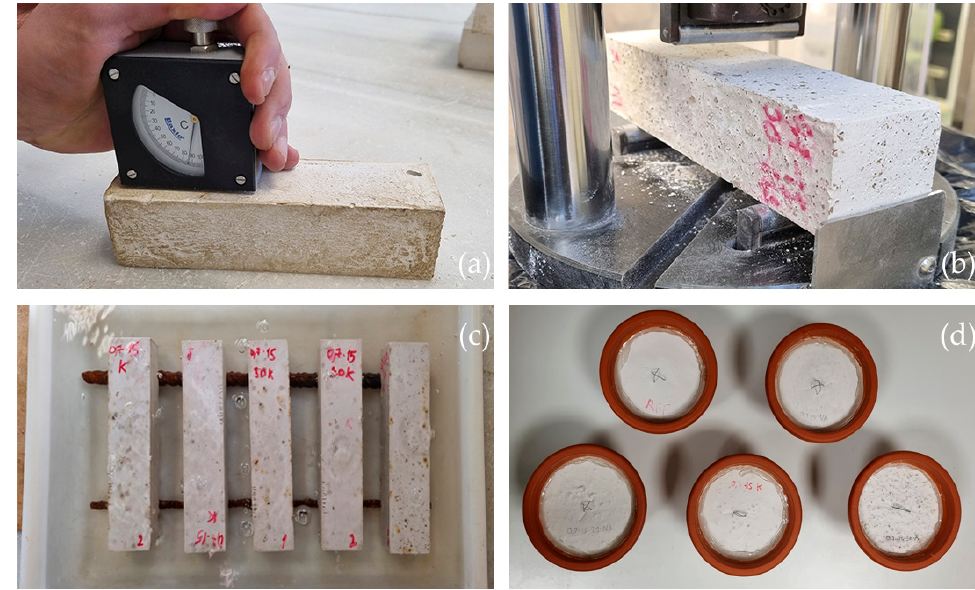
Figure 2. Tests performed: ( a ) surface hardness; ( b ) flexural and compressive strength; ( c ) total water absorption; ( d ) water vapour permeability.